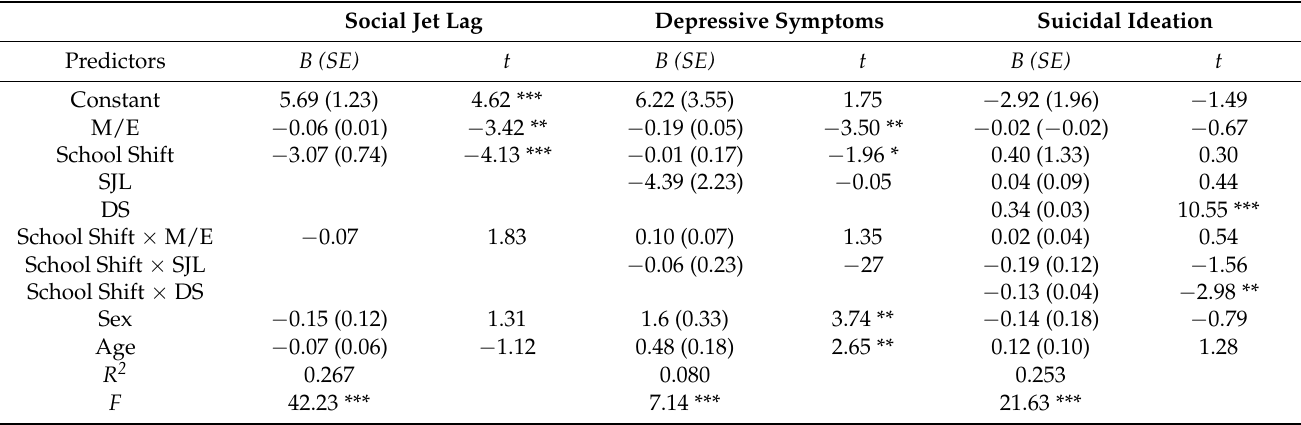
Table 7. Morningness/eveningness (M/E) effect on suicidal ideation through social jet lag (SJL) and depressive symptom (DS) mediators, with school shift as moderator and sex and age as